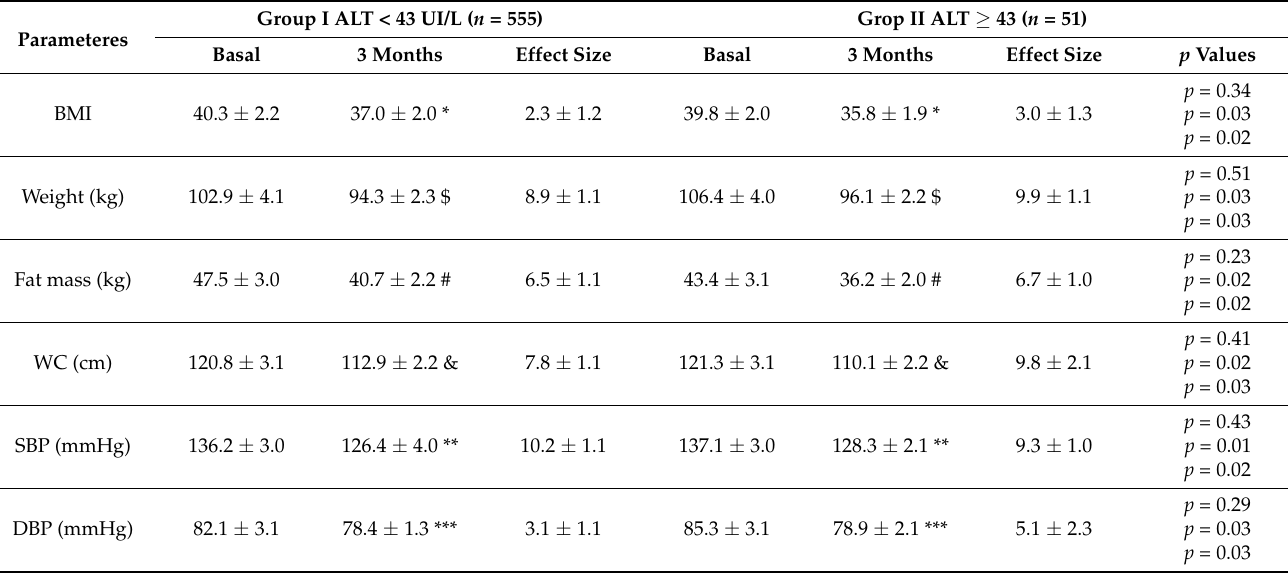
Table 4. Anthropometric parameters and blood pressure in different groups (mean ± standard deviation) at baseline time and after 3 months of intervention.